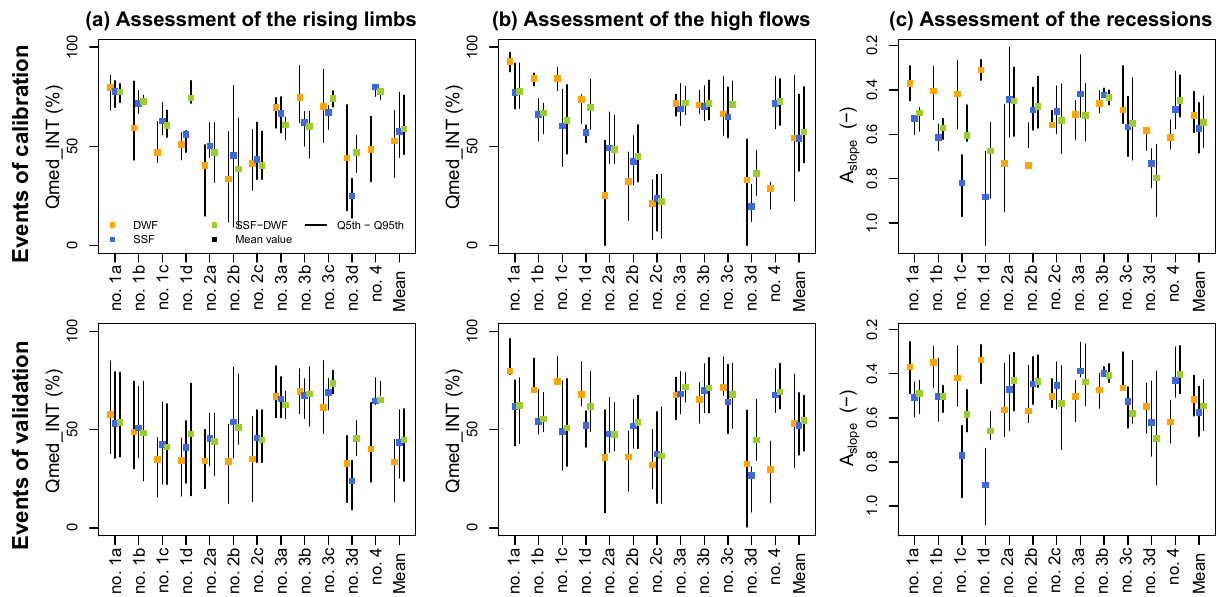
Figure 8. Assessment of the models by catchment in the different stages of the hydrographs. (a) : Qmed_INT scores calculated over the rising flood waters stage. (b) : Qmed_INT scores calculated over the high discharges stage. (c) : A slope scores. High Qmed_INT scores and conversely low A slope values indicate good performances of the model.